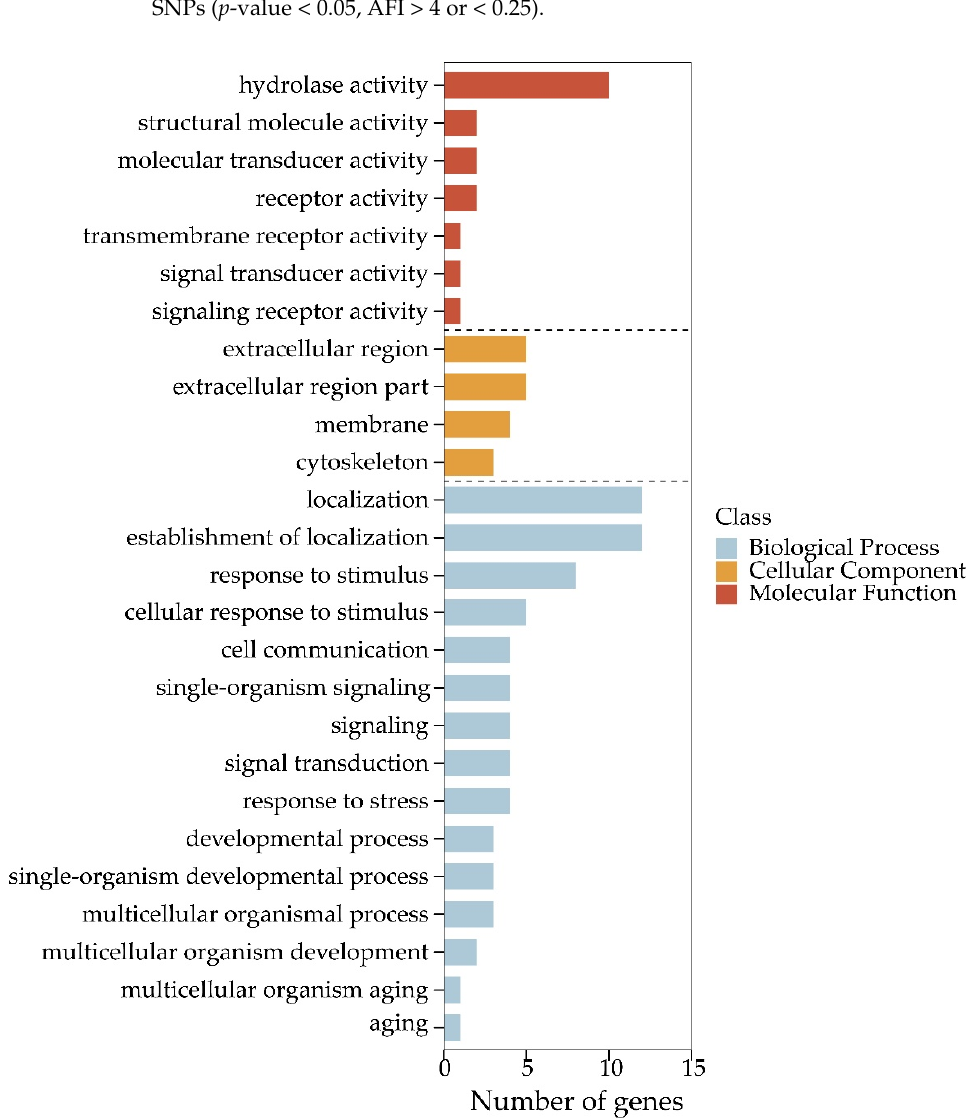
Figure 4. Venn diagram. DEGs represent differently expressed genes between RG (rapid-growing individuals) and SG (slow-growing individuals). FGs represent functional genes containing candidate SNPs ( p -value < 0.05, AFI > 4 or < 0.25).